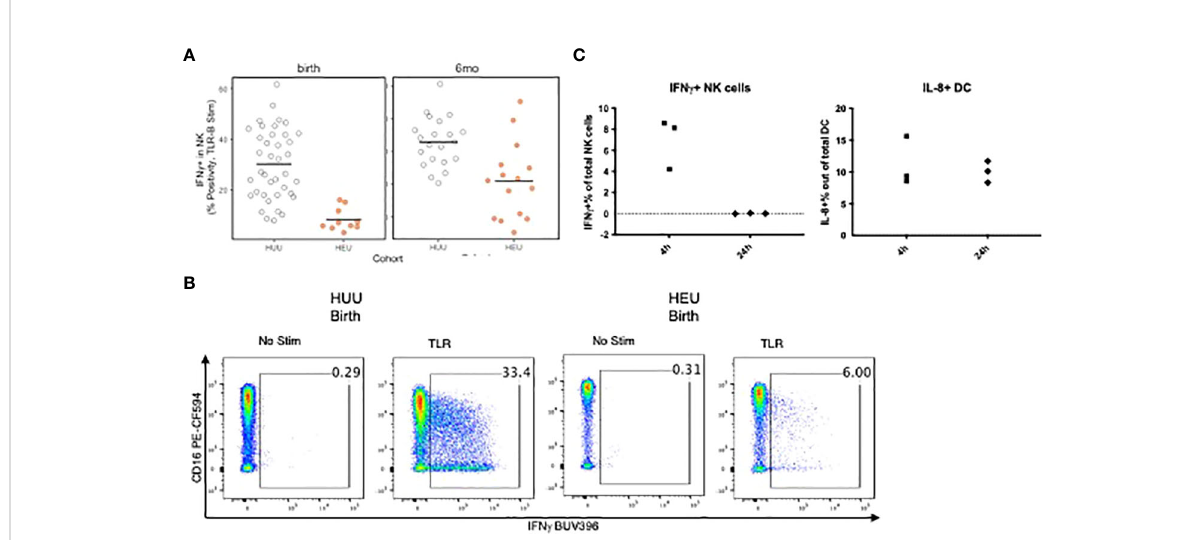
FIGURE 5 Requirement of APC-secreted factors for NK cell activation in TLR-stimulated PBMC. (A) : Scatter plots comparing NK expression of IFNg in HEU and HUU PBMC stimulated with TLR agonists for 24 h Data were derived from 10 HEU at birth, 15 HEU at 6 months, 39 HUU at birth and 21 HUU at 6 months. Dots represent individual participant results. Horizontal lines indicate the medians. (B) Representative fl ow scatter plots for the differences in IFNg+ NK cells between HEU and HUU. (C) Scatter plots show the effect of blocking cytokine secretion for the entire 24-h stimulation period compared with blocking for the last 4 h of stimulation on activation of NK cells (left) and DC (right). The dots represent the frequency of activated cells in TLR-stimulated conditions after subtraction of unstimulated control. Blocking cytokine export during the entire 24 h period of stimulation completely abrogated NK cell responses, but not DC responses, indicating that NK responses depended on APC- derived cytokine stimulation, whereas DC were directly stimulated by the TLR